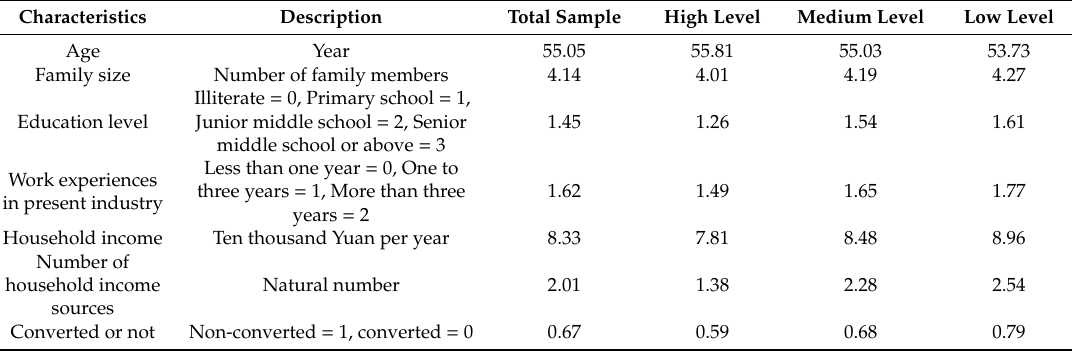
Table 3. Characteristics of fishermen with di ff erent levels of the livelihood vulnerability index (LVI; mean